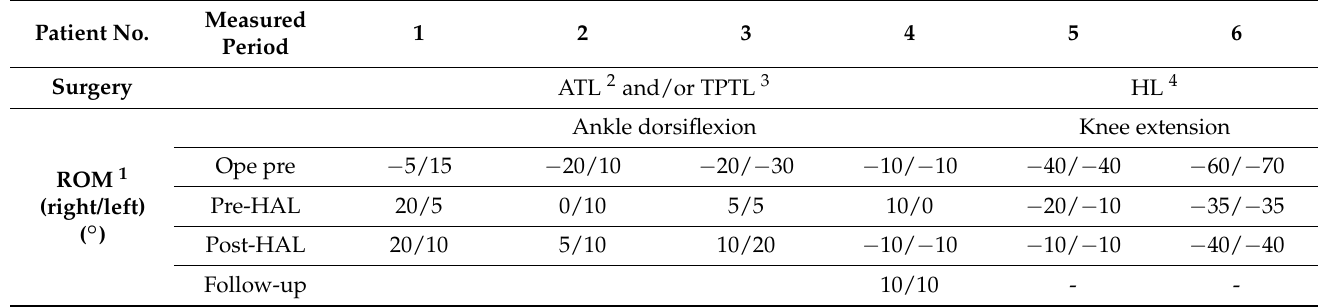
Table 3. Clinical outcomes.